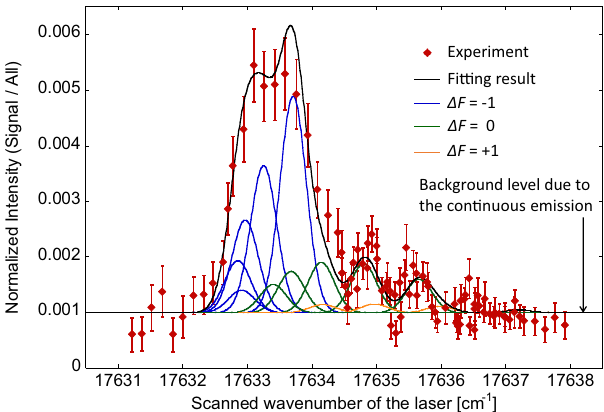
Fig. 4 Experimental LIF spectrum. The fi tting result (black line) is shown with separated pro fi les (blue, green, and orange lines) for every transition. The error bar for each experimental data point (red diamond) represents the statistical error.